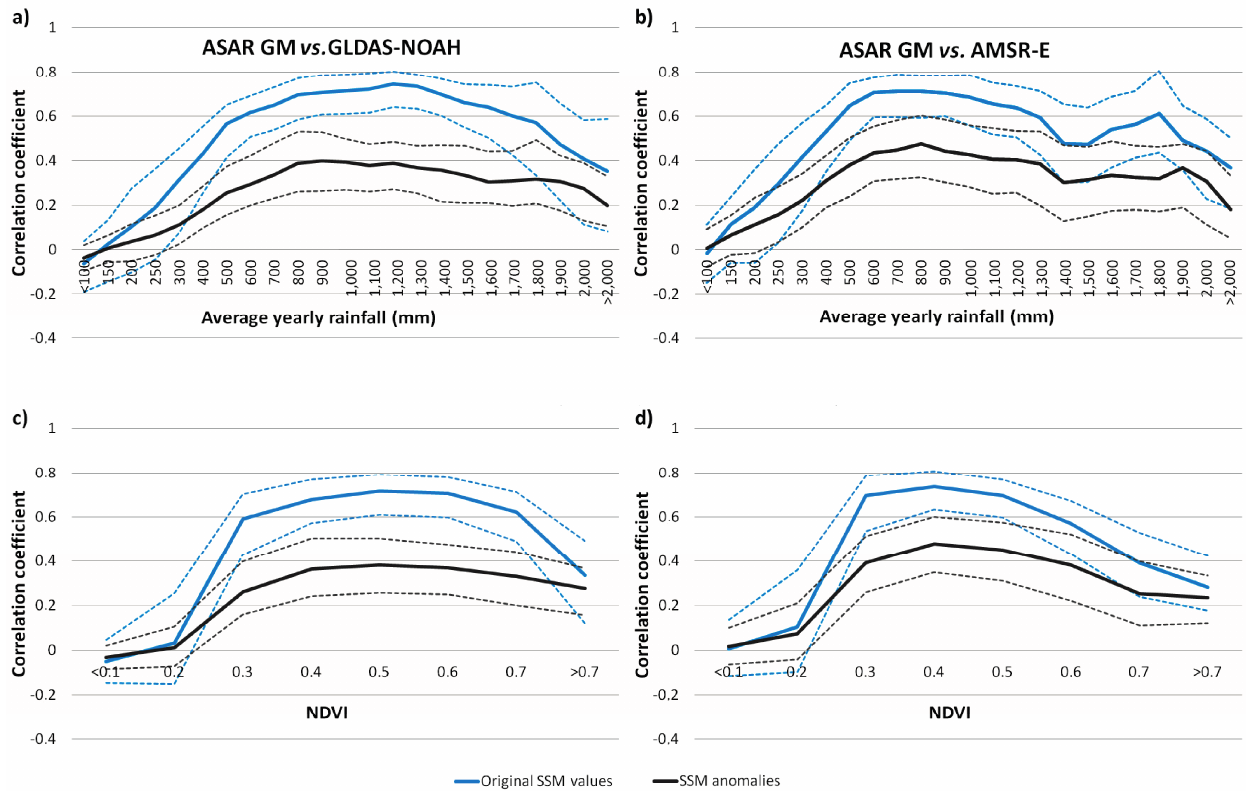
Figure 4. ( a , b ) The correlation coefficient ( R ) as a function of average precipitation for the Advanced Synthetic Aperture Radar (ASAR) Global Monitoring (GM) Surface Soil Moisture (SSM) vs. the Noah model from the Global Land Data Assimilation System (GLDAS-NOAH) and Advanced Microwave Scanning Radiometer for Earth Observing System (AMSR-E) SSM, respectively; ( c , d ) R as a function of average Normalized Difference Vegetation Index for ASAR GM SSM vs . GLDAS-NOAH and AMSR-E SSM, respectively. The solid line represents the median value; dashed lines represent the 25th and the 75th